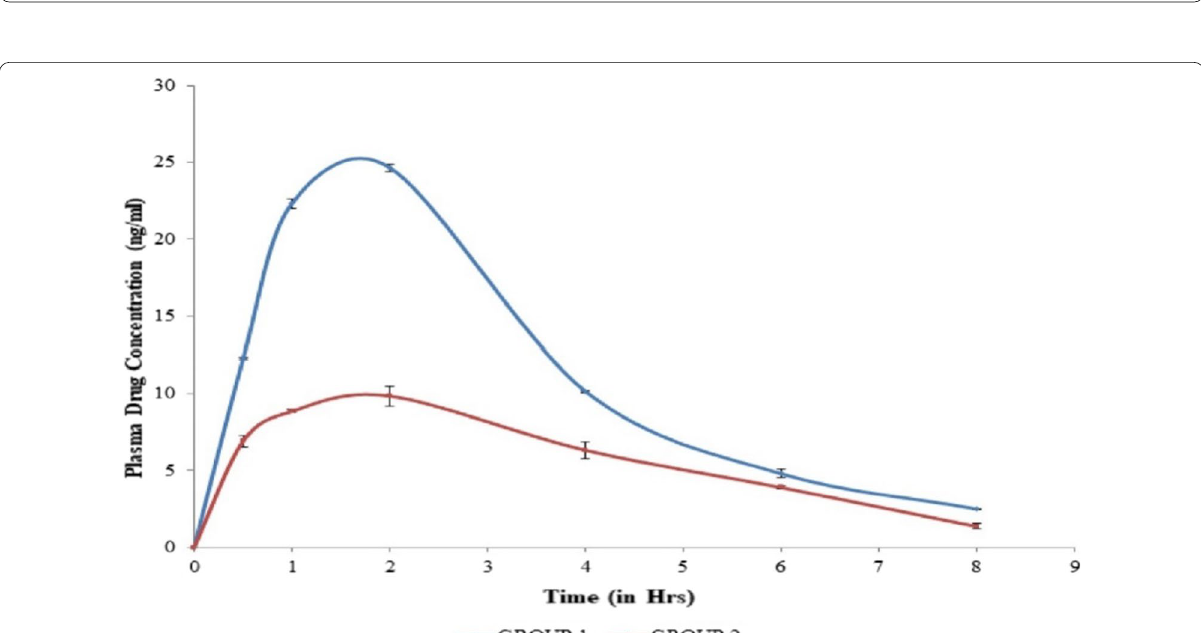
Fig. 5 Plasma concentration of vorinostat versus the time profiles of group I (SMEDDS 10 mg/kg) and group II (vorinostat in suspension 10